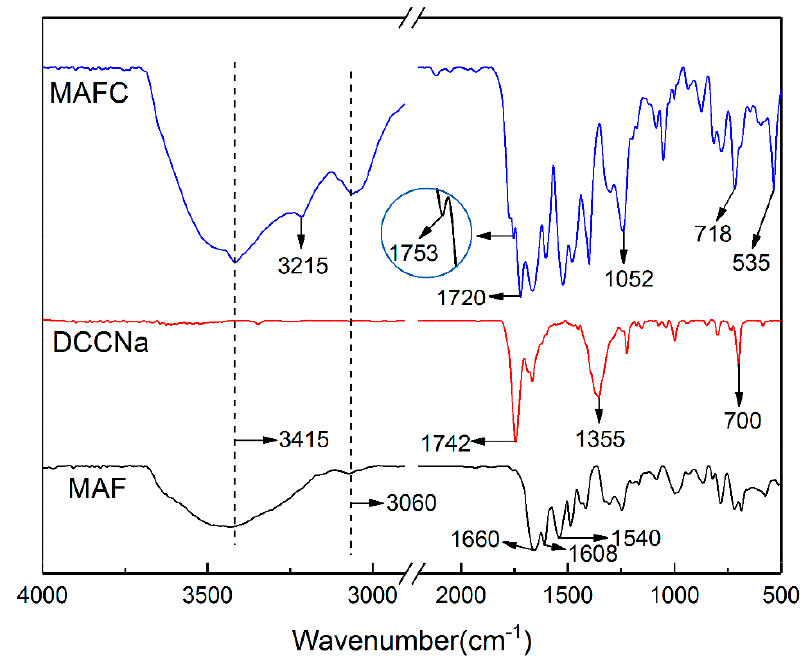
Figure 2. Fourier-transform infrared spectroscopy (FTIR) spectra of MAF, sodium dichloroisocyanurate solution (DCCNa), and MAFC.